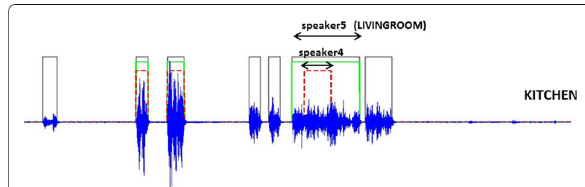
Fig. 9 Example of the proposed room-localized SAD system output for the kitchen of the DIRHA smart home, shown in green when operating over the entire first-stage segments (depicted in black), or in red dashed line when operating over shifting windows. The